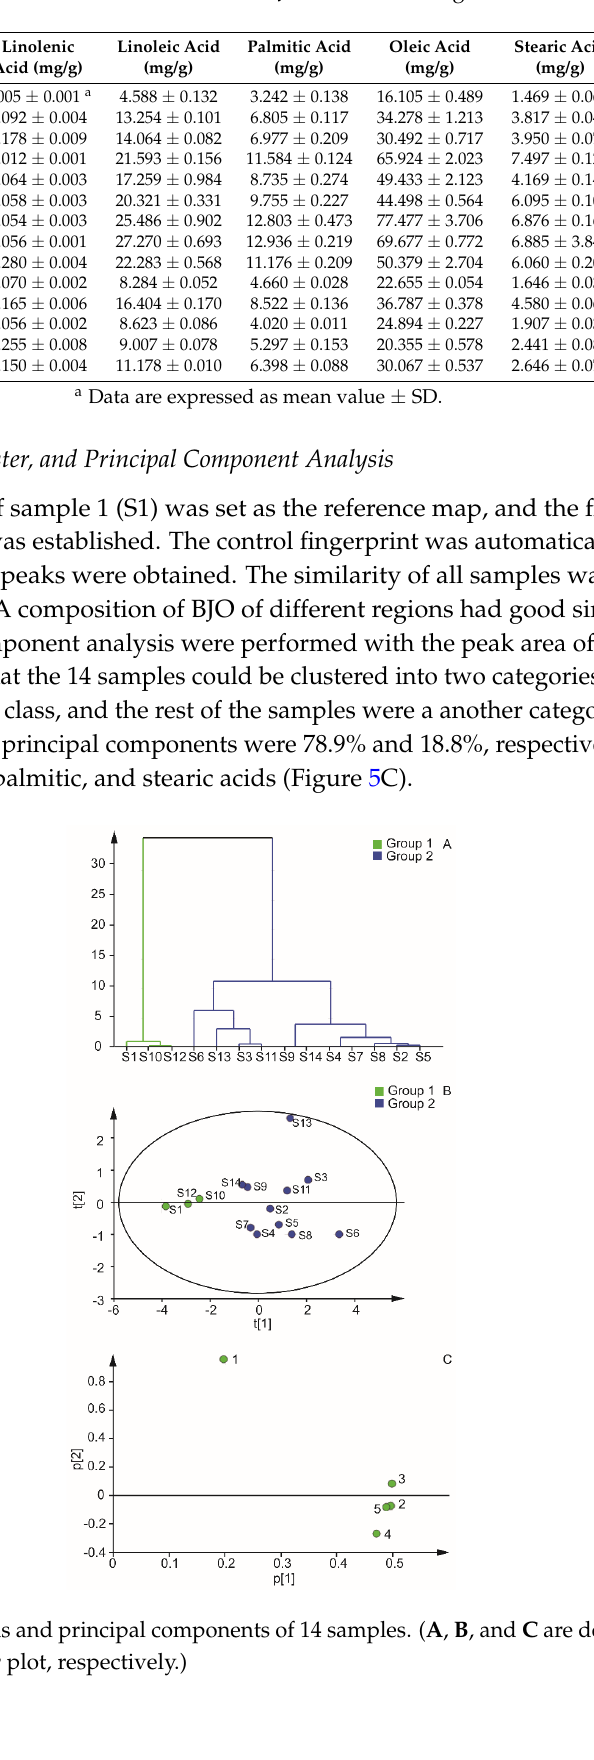
Table 5. FA contents of BJO of different origin.